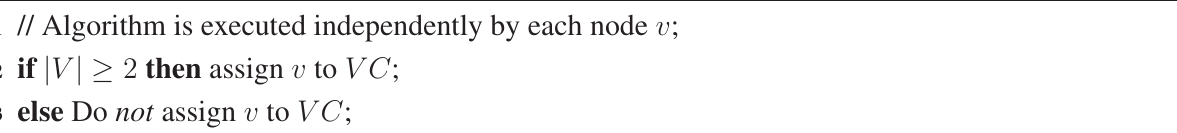
Algorithm 7 : Local algorithm for computing a vertex cover for a unit disk graph G = ( V, E ) // Algorithm is executed independently by each node v ;